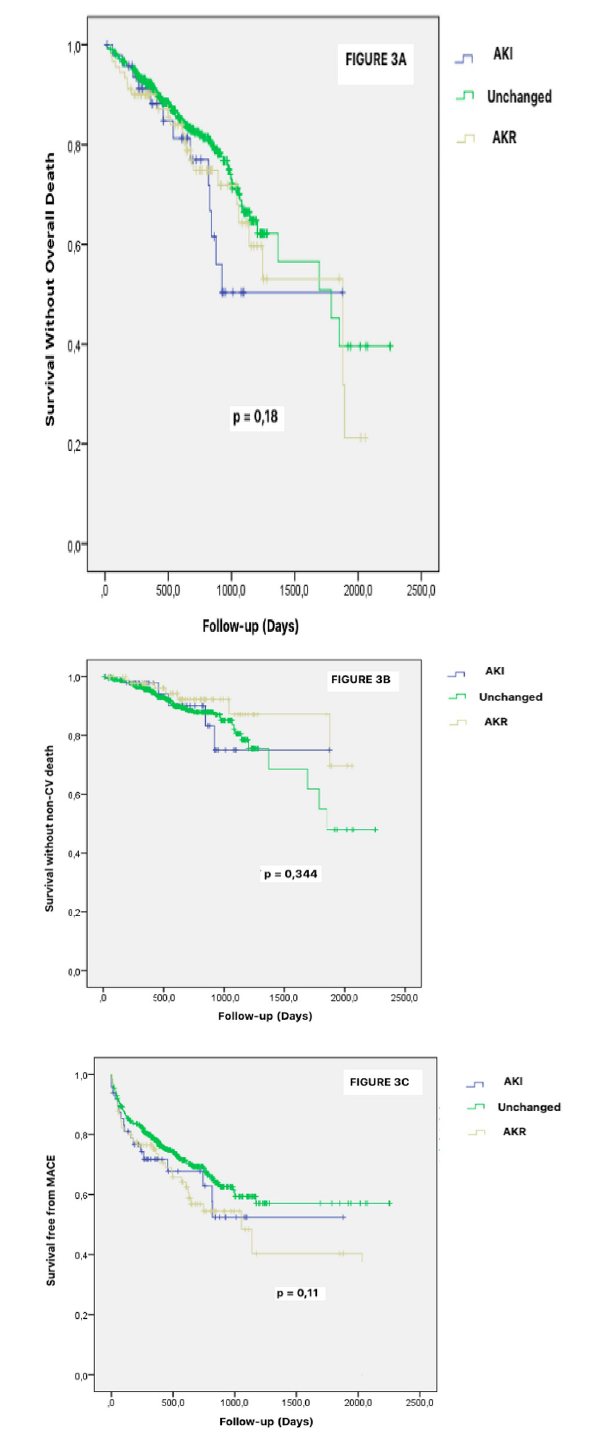
Fig 3. Impact of Acute kidney injury (AKI), Acute kidney recovery (AKR) and unchanged renal function after TAVR on overall death, non-cardiovascular death and MACE. Kaplan–Meier analysis for the probability of survival free overall death death (Fig 3A), non-cardiovascular death (Fig 3B) and MACE (Fig 3C) after TAVR according to renal variations including altered (AKI) and unchanged or improved (AKR) renal function. Abbreviations : AKI = Acute Kidney Injury. AKR = Acute Kidney Recovery. CV = Cardiovascular. TAVR = Transcatheter Aortic Valve Replacement.